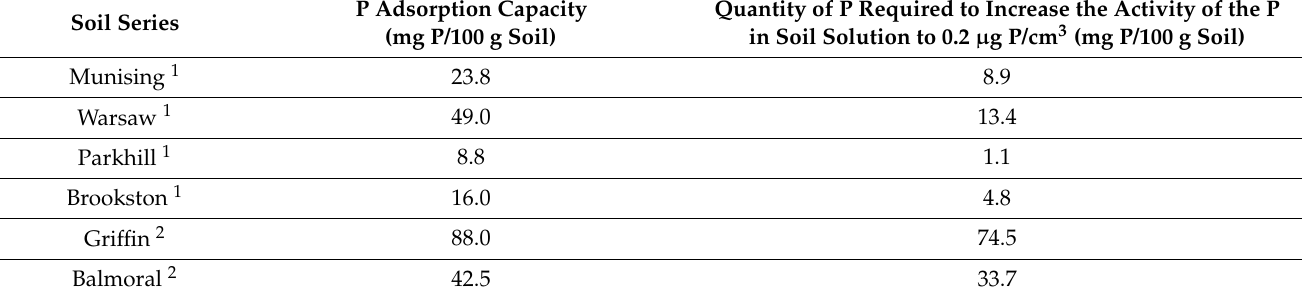
Table 2. Comparison between the P fixing capacities of upper subsoils of soils from Michigan, USA, and highly weathered soils from KwaZulu-Natal Province, South Africa (Adapted from Elis [21]). P Adsorption Soil Series